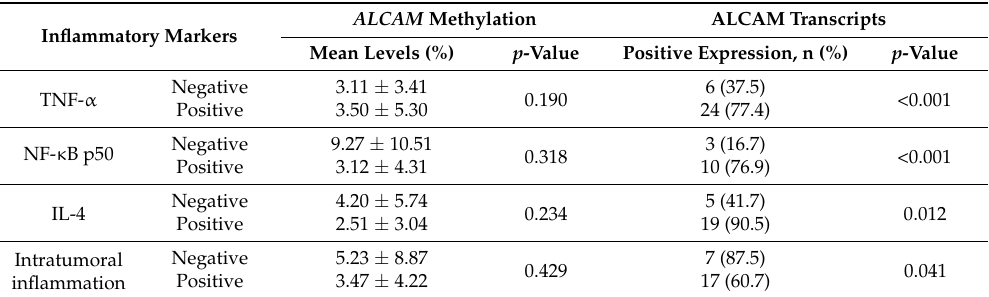
Table 2. Association of methylation levels of the ALCAM gene and its expression with other inflammatory markers in tumor tissues.